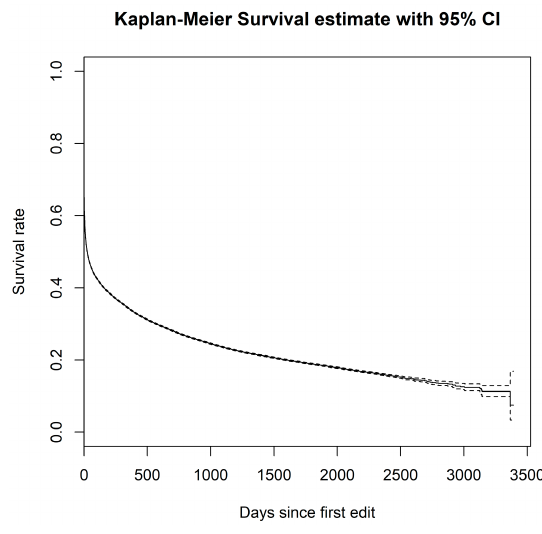
Figure 3. Survival curve of OSM contributors with 95% confidence intervals.